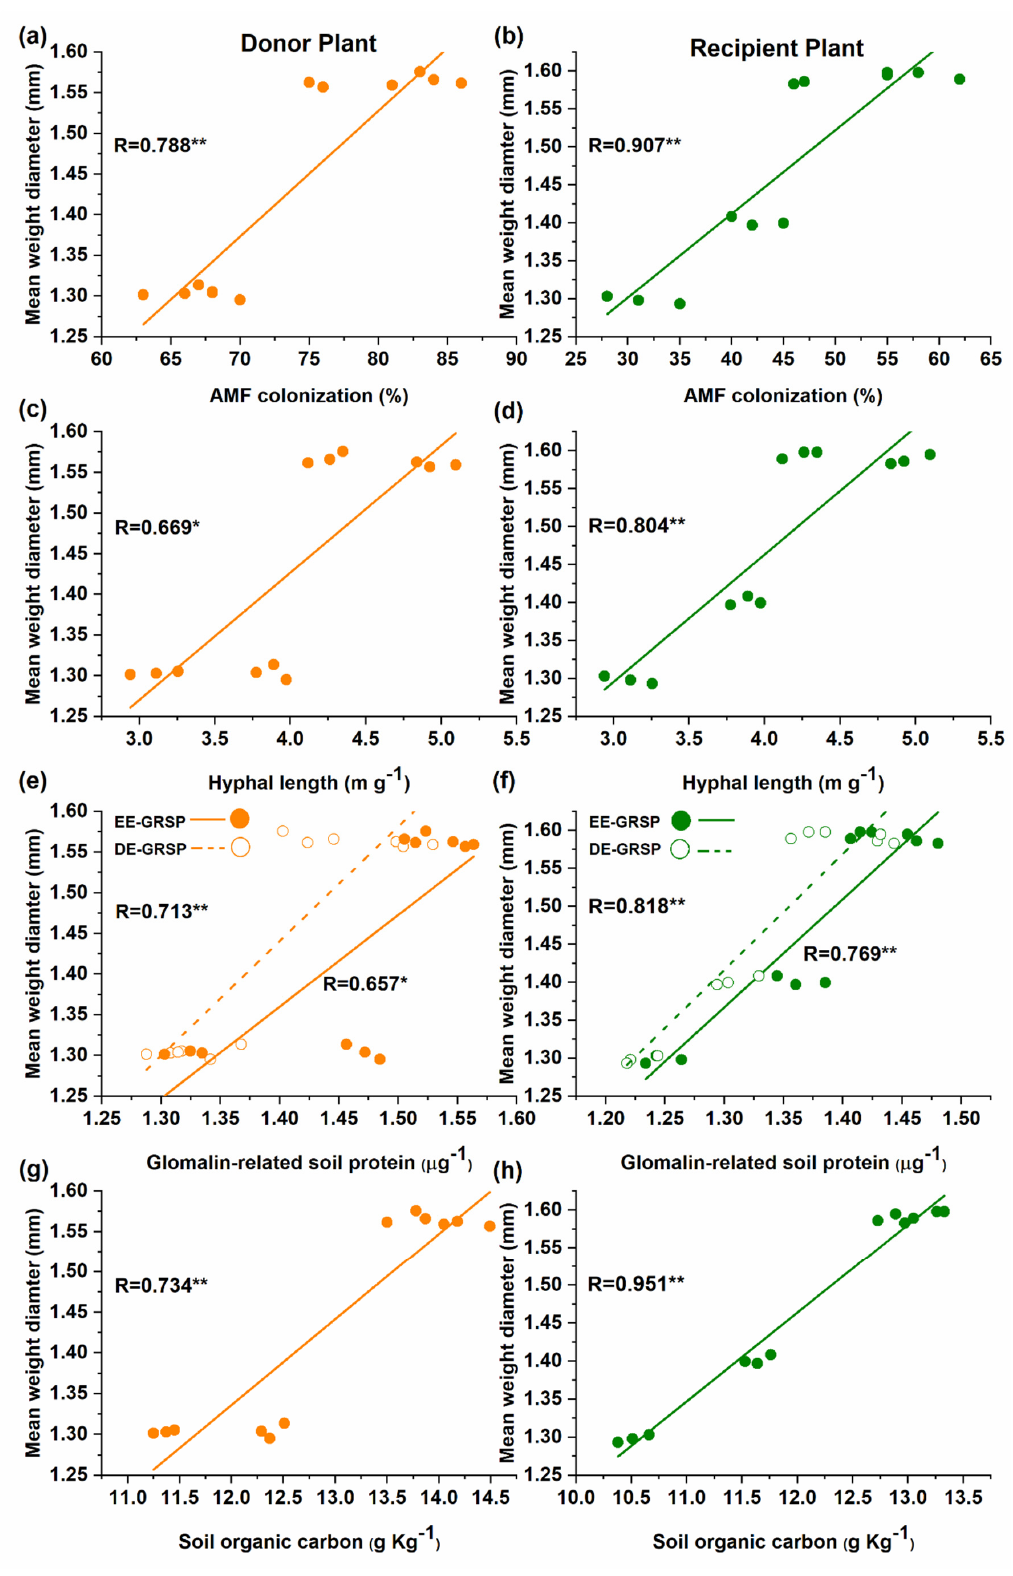
Figure 5. Linear correlation in the donor and recipient plants between mean weight diameter (MWD) and; ( a , b ) colonization or; ( c , d ) hyphal length or; ( e , f ) glomalin-related soil proteins (GRSPs) fractions or; ( g , h ) soil organic carbon (SOC) in mycorrhizal treatment (n = 12).